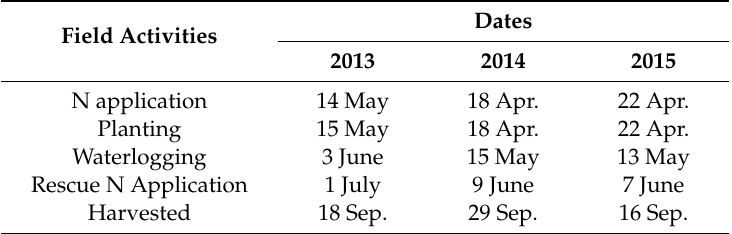
Table 1. Dates for field activities from 2013 to